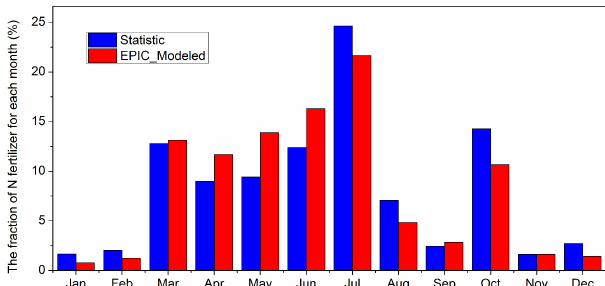
Figure 5. Comparison of the fraction of N fertilizer use by each month between statistics and EPIC